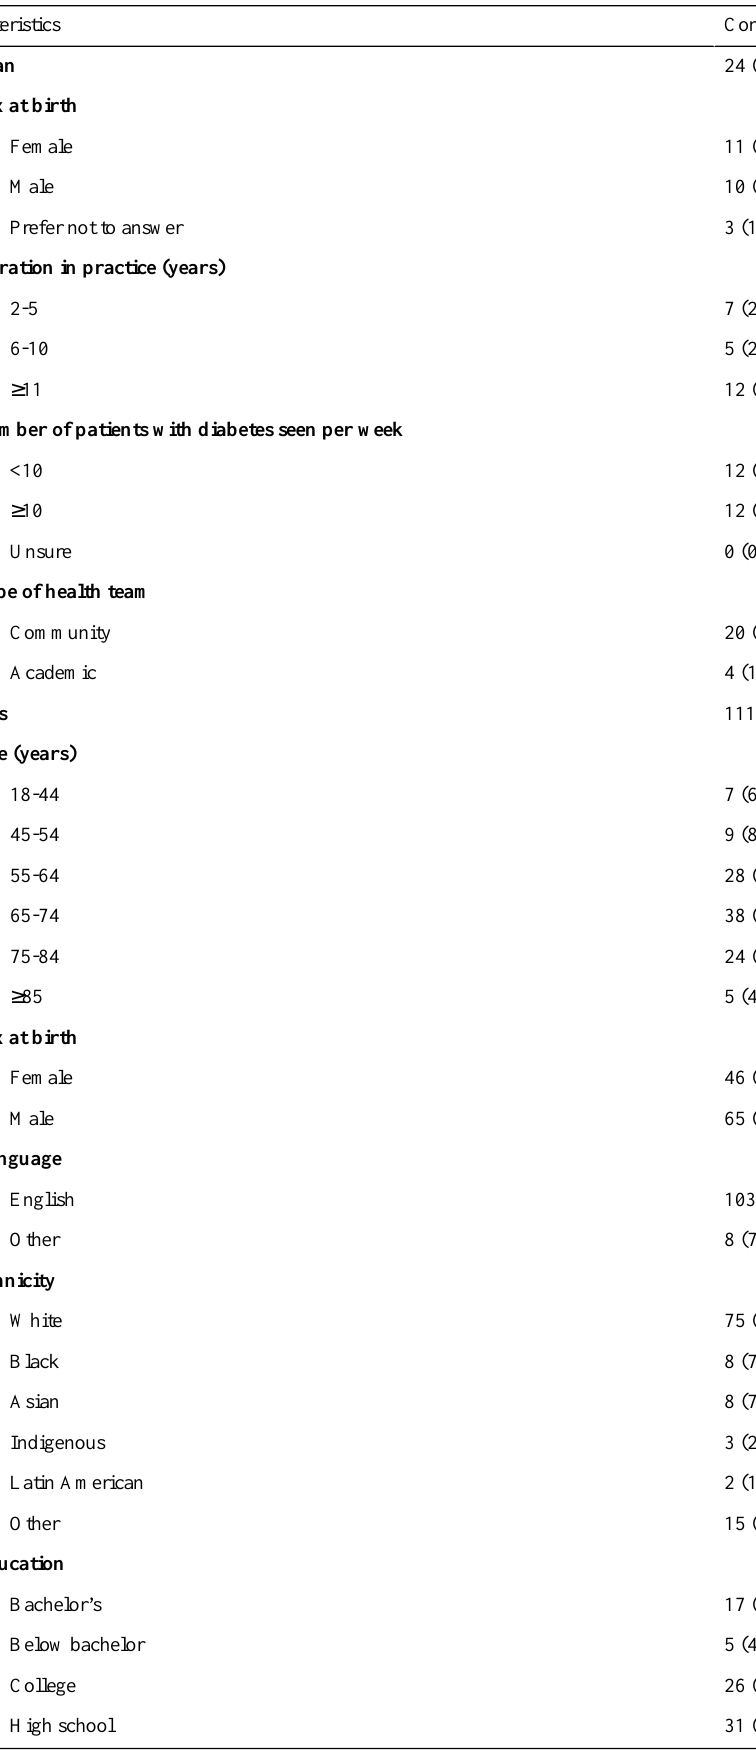
Table 2. Clinician and patient